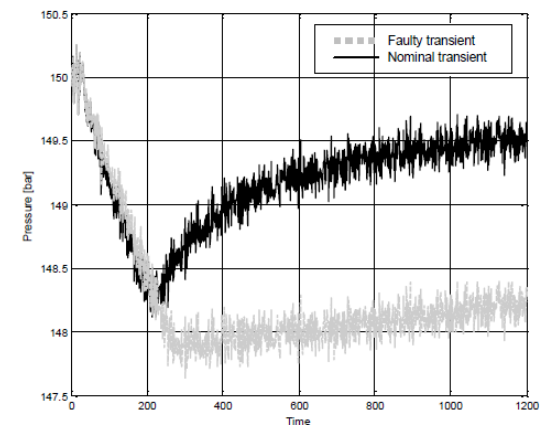
Fig. 15. Evolution of the pressure for a nominal transient and the faulty transient.